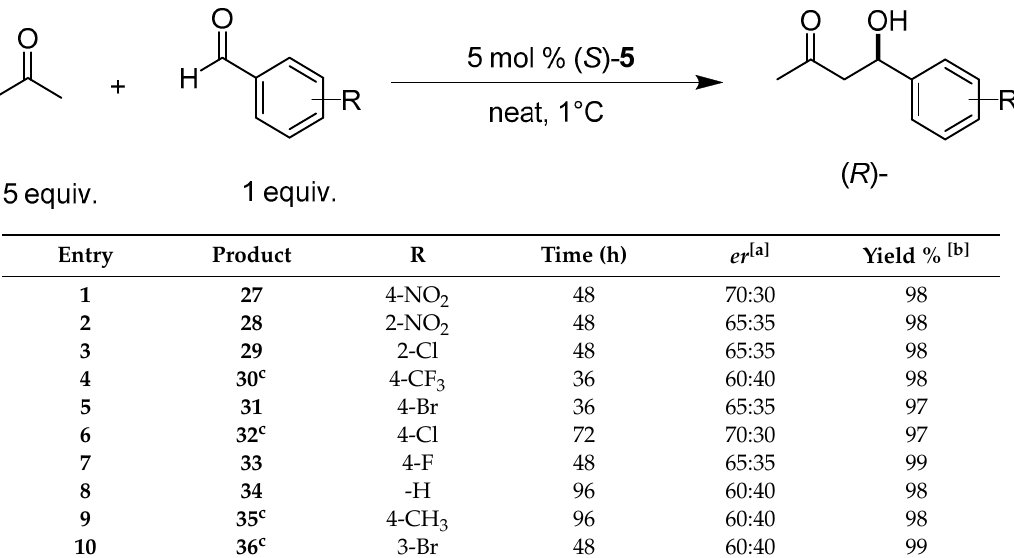
Table 3. Asymmetric aldol reaction between acetone and aromatic aldehydes employing ( S )- 5 as catalyst.